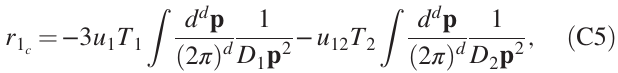
FIG. 8. Diagrammatic representation of Gaussian propagators. Solid (dotted) lines correspond to classical (response) fields. The two fields are later distinguished by thickness and color. In this figure, we have shown (a) the response propagator and (b) the correlation propagator.